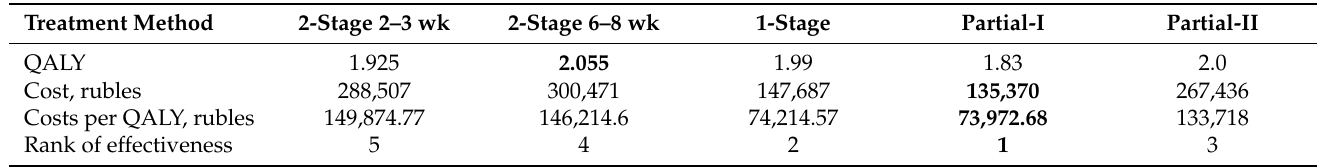
Table 7. Average costs for treatment methods in the prospective group according to the Markov model